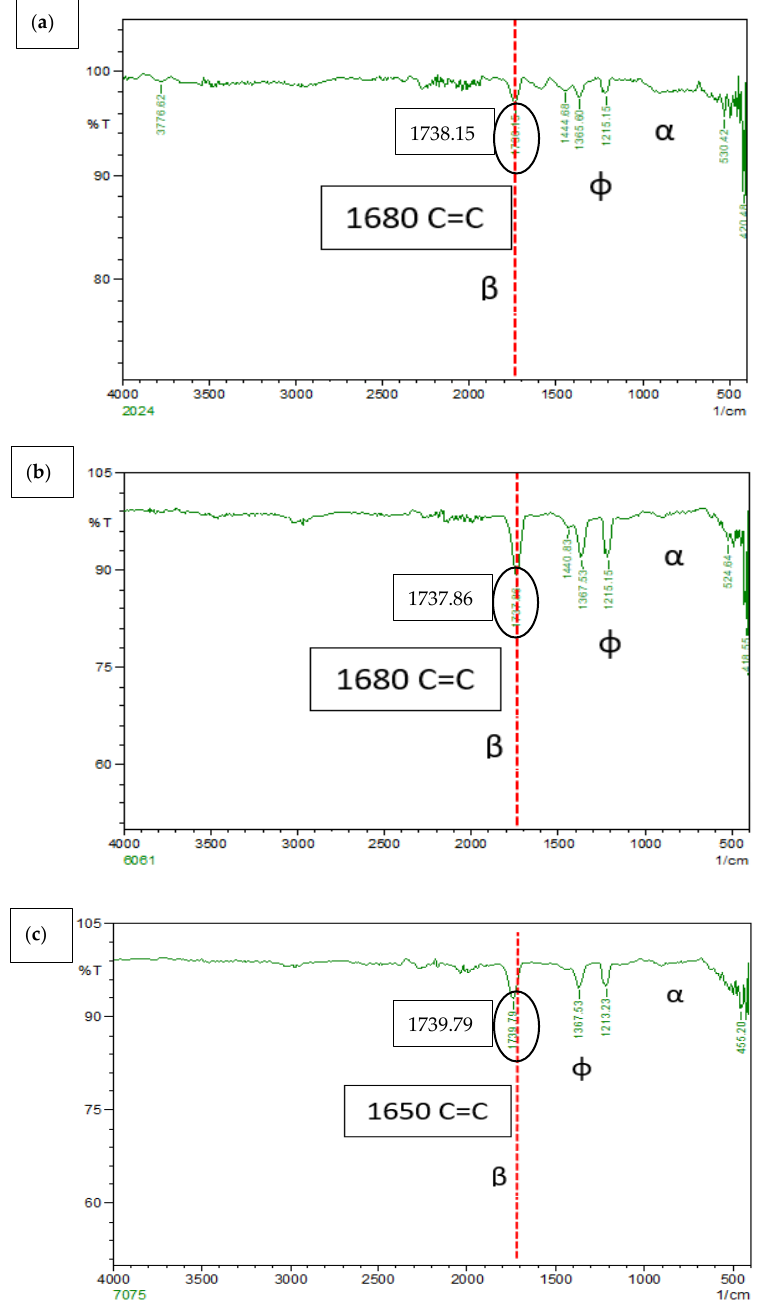
Figure 12. FTIR peaks for Microwave processed and hot extruded ( a ) 2024 + Gr, ( b ) 6061 + Gr and ( c ) 7075 + Gr. The stretching vibrations of sp 2 C=C bonds peak, which is specific to the asymmetric flaky carbon in the form of graphene nano particles (GNPs) appearing at 1670 cm − 1 in the spectrum recorded for the AA 7075 2 wt% Gr composite ( β ) [22]. Yet, a similar peak appeared in AA 6061 and AA 2024 2 wt% Gr at 1680 cm − 1 with a stronger intensity